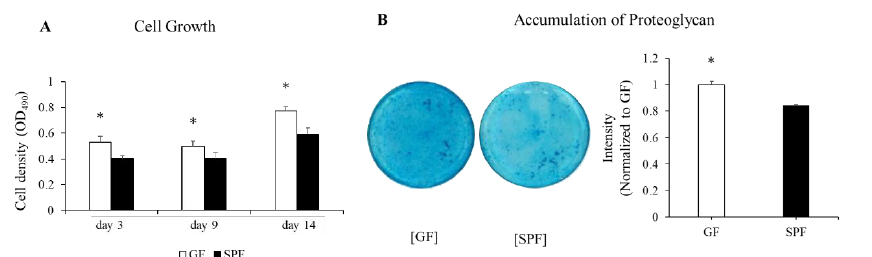
Figure 3. The effects of maternal microbiome on proliferation and accumulation of extracellular matrix in fetal chondrocytes from GF and SPF lib cages. ( A ) Cell proliferation, ( B ) (left) accumulation of Proteoglycan stained with Alcian Blue, (right) staining intensity measured by FIJI/ImageJ. The data are presented as mean ± SD ( n = 3, t -test, * p < 0.05). OD = optical density.